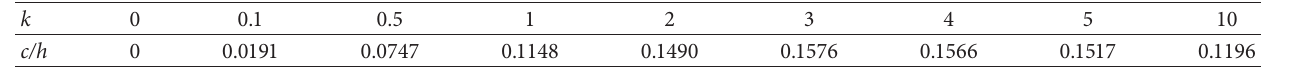
Table 2: The variation of the physical neutral surface to the power-law index.